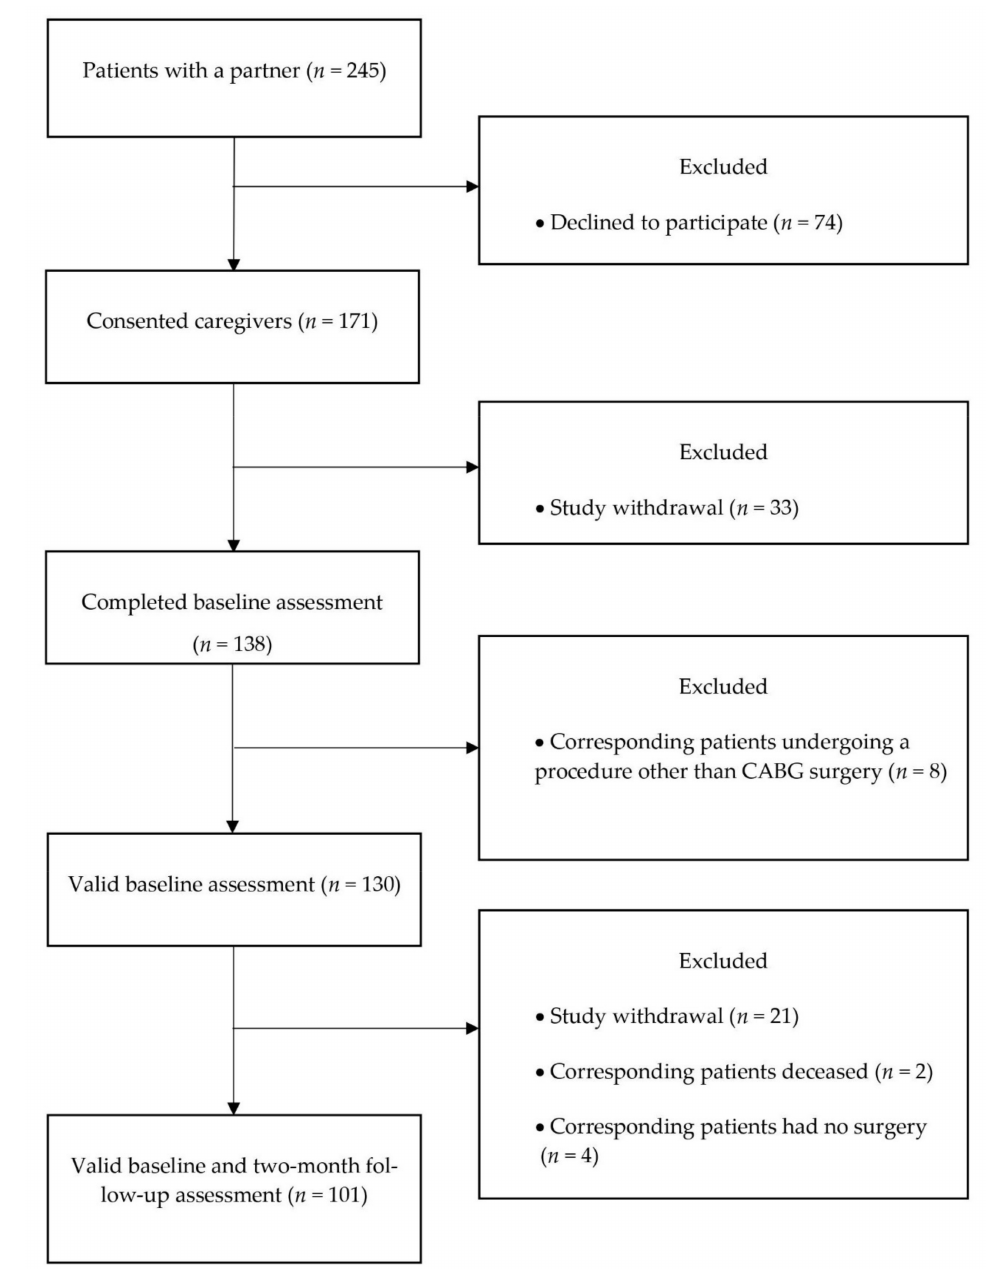
Figure 1. Flow diagram of caregiver participants’ progression through the ARCS (Adjustment and Recovery after Cardiac Surgery) study. Coronary artery bypass graft